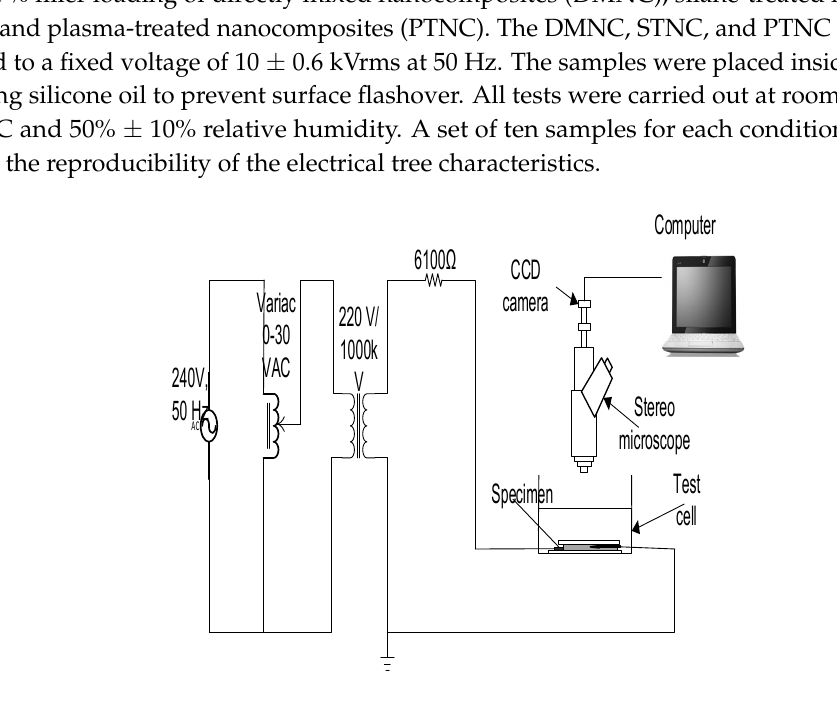
Figure 3. Experimental setup for electrical tree growth monitoring.